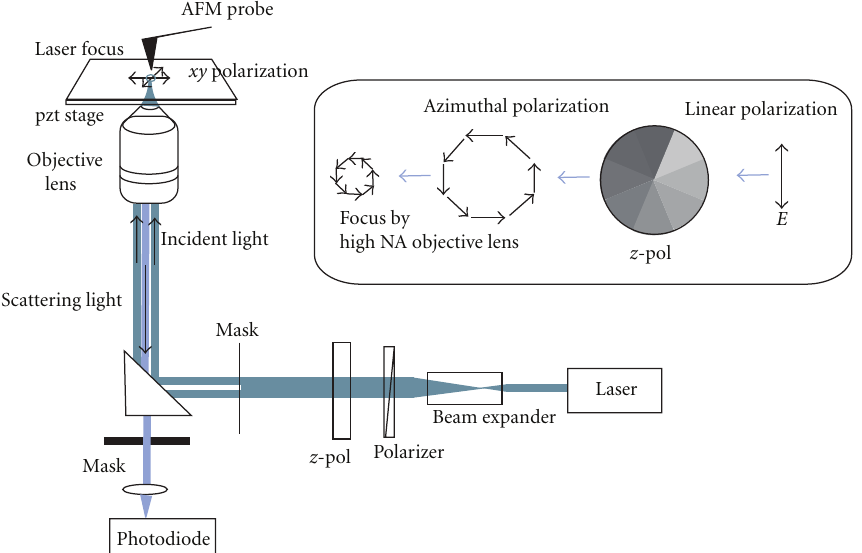
Figure 1: Experimental setup of near-field probe scanning over the laser focus in s -polarization condition. The inset illustrates a schematic of s -polarization formation by using z -pol.